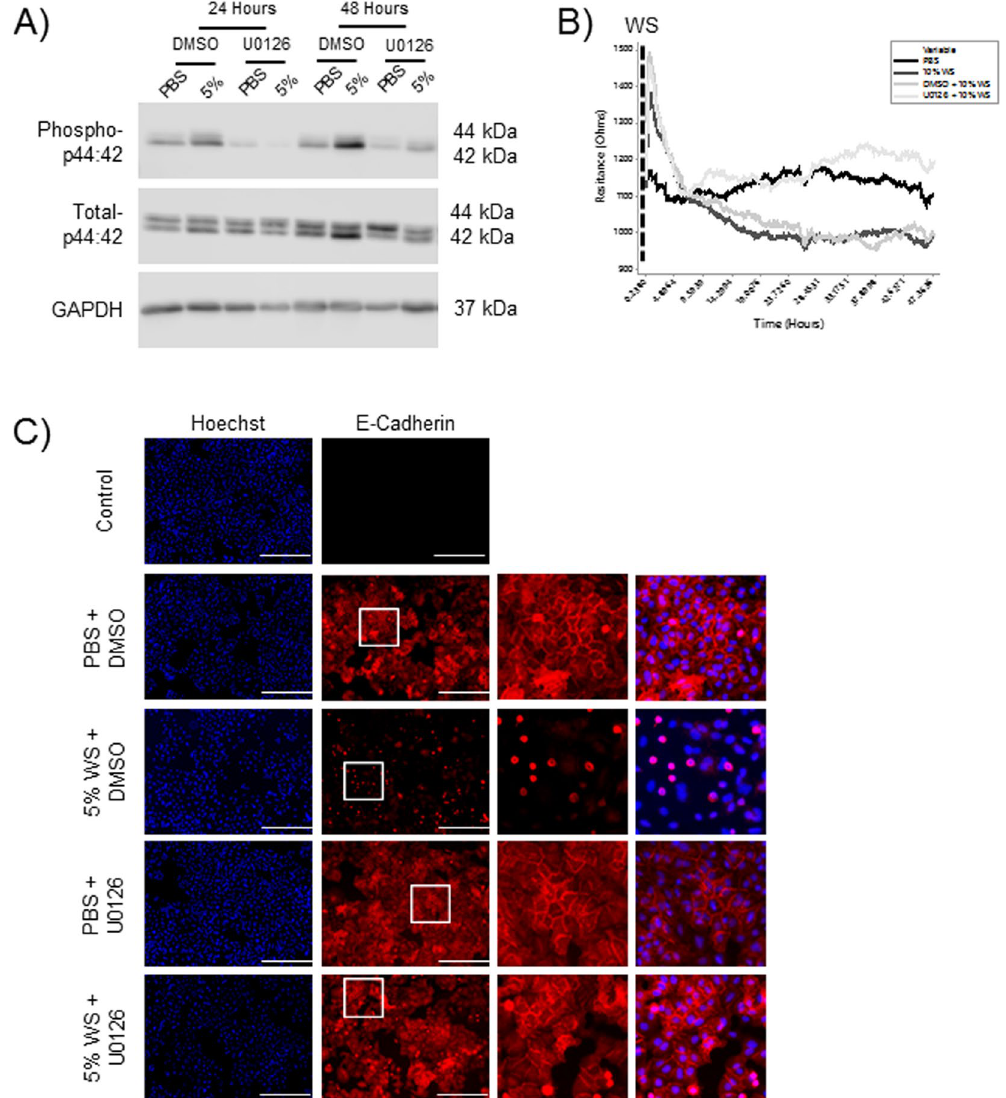
Figure 7. U0126 Prevents Wood Smoke Mediated Epithelial Dysfunction. Pre-treatment of A549 cells with 10 µ M U0126 for 60 minutes prior to WS exposure prevented ( A ) p44/42 phosphorylation and ( B ) a reduction in epithelial resistance. (Dashed line – start of wood smoke treatment). ( C ) 24 hours of WS exposure resulted in the loss of membrane E-cadherin staining and cellular accumulation. However, pre-treatment with U0126 partially prevented loss of membrane E-cadherin staining as characterized by the preserved cobble stone patterning (scale bars = 400 µ m; n = 3). Full blots are provided in Supplementary Fig.